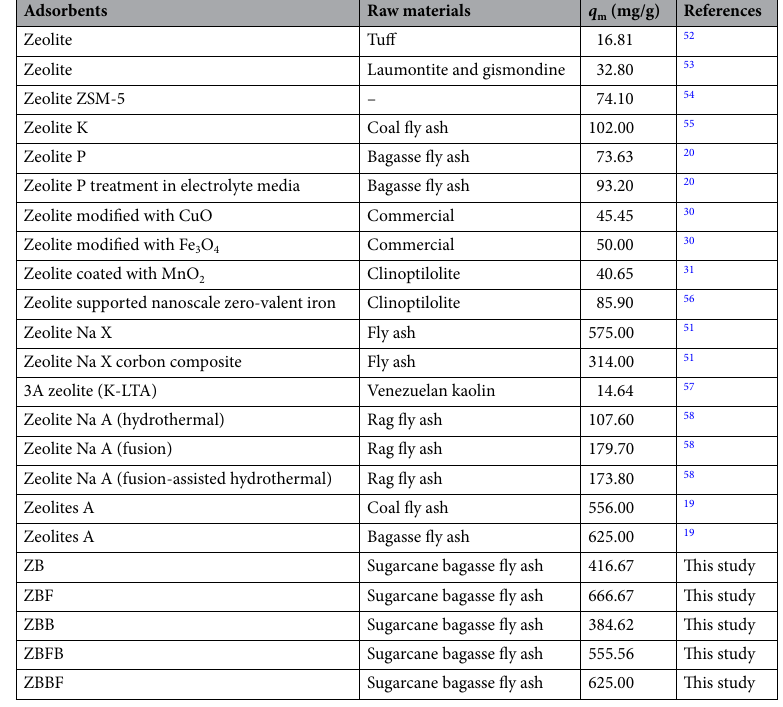
Table 4. Comparison of the maximum adsorption capacity of various zeolite adsorbents for lead